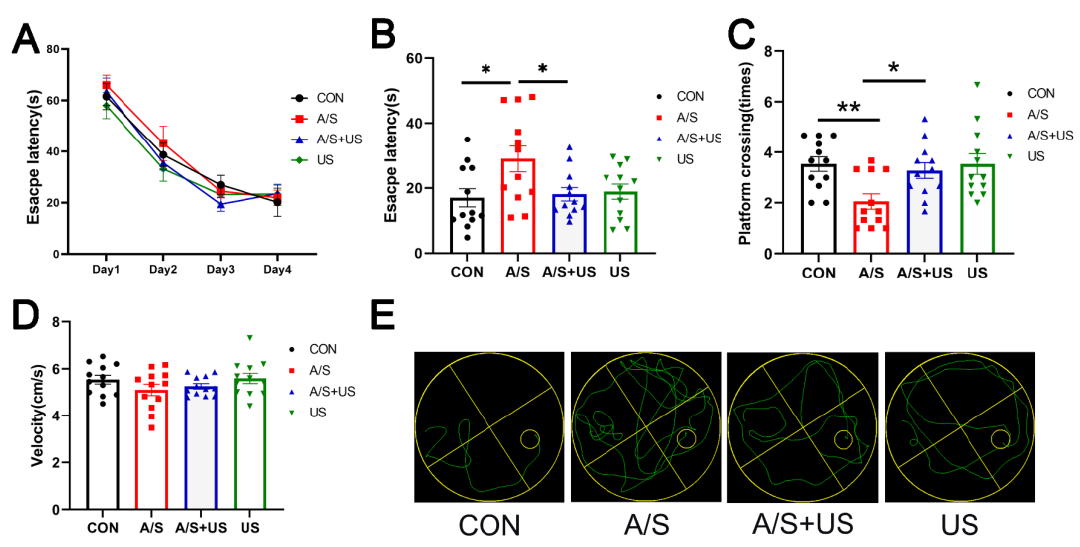
Figure 3. LIPUS improves hippocampus-dependent learning and memory after anesthesia/surgery in aged mice. ( A ) Escape latency in the training stage before anesthesia/surgery. ( B ) Escape latency one day after LIPUS application. ( C )Platform crossing times 1 day after anesthesia/surgery after LIPUS application. ( D ) Swimming speed of four groups during the process of testing. ( E ) The representative swimming trajectories of the four groups during the Morris water maze test. n = 12 per group. Data were presented as Mean ± SEM. * p < 0.05, ** p < 0.01.